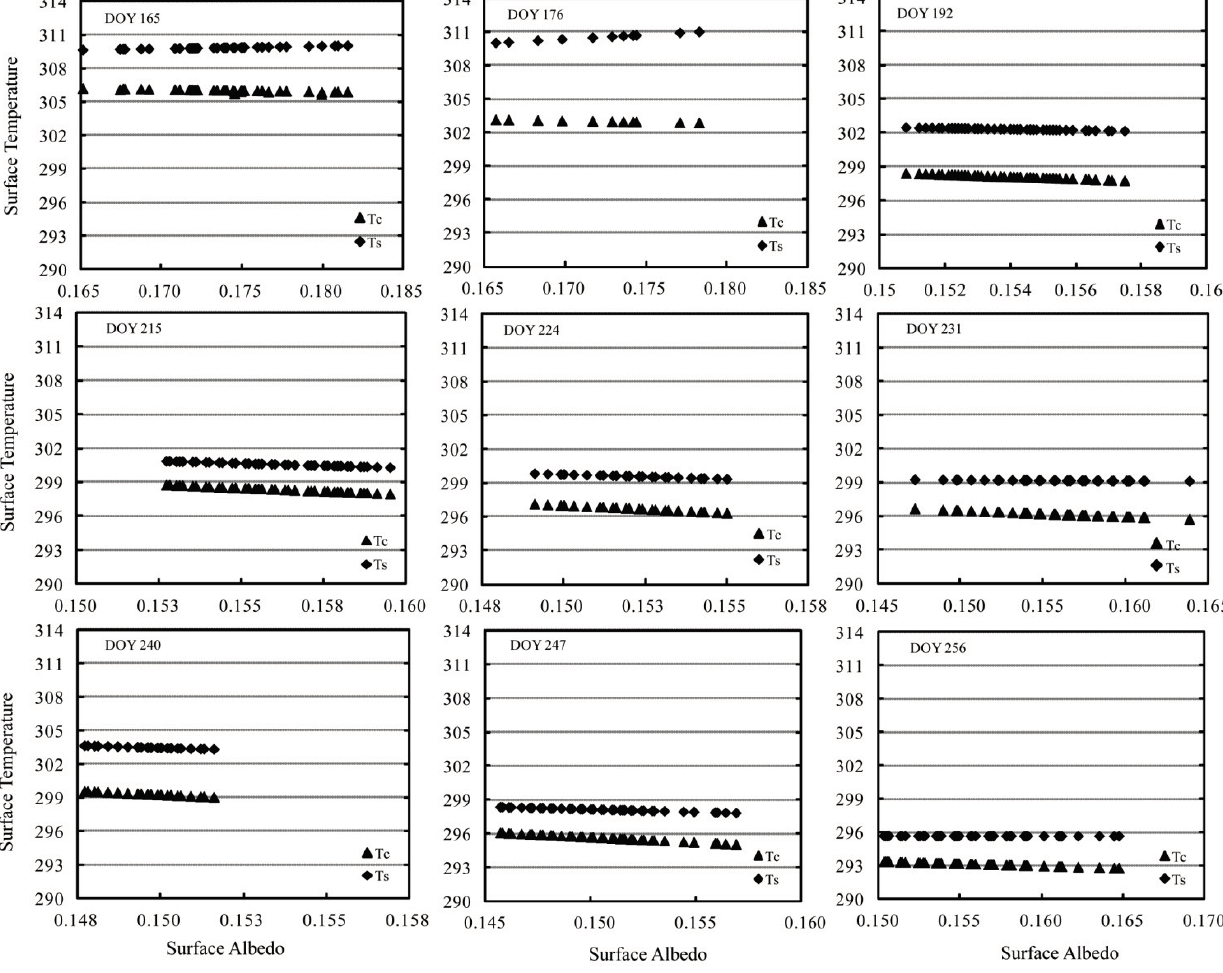
Figure 7. Evaluations in separated soil temperatures and vegetation temperatures at the water stress iso-line at the ASTER overpass